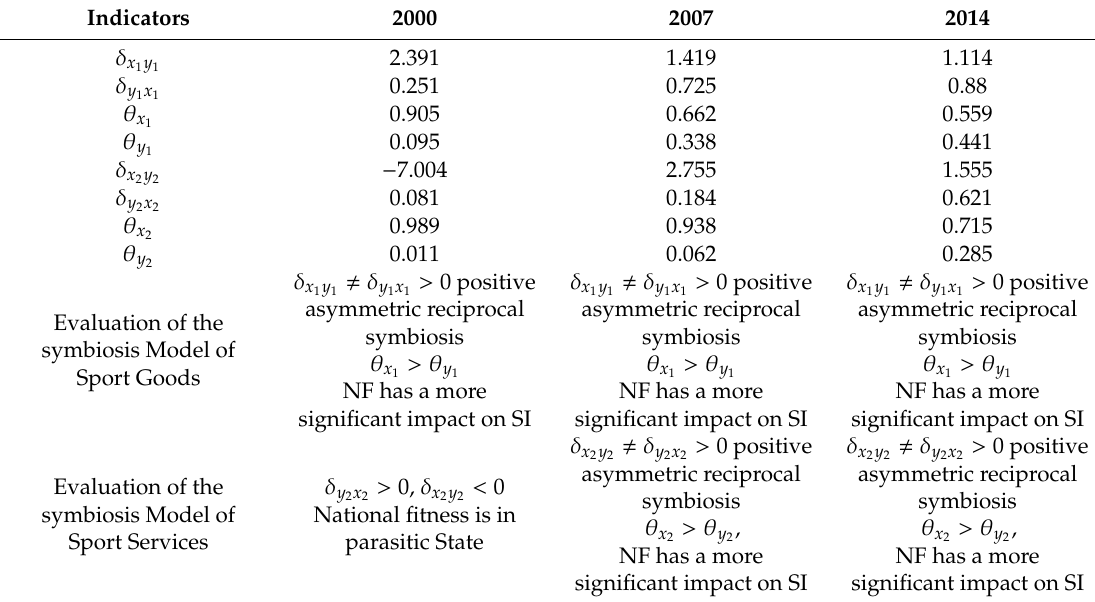
Table 4. Symbiosis degree and model of sport goods and sport services in NF and